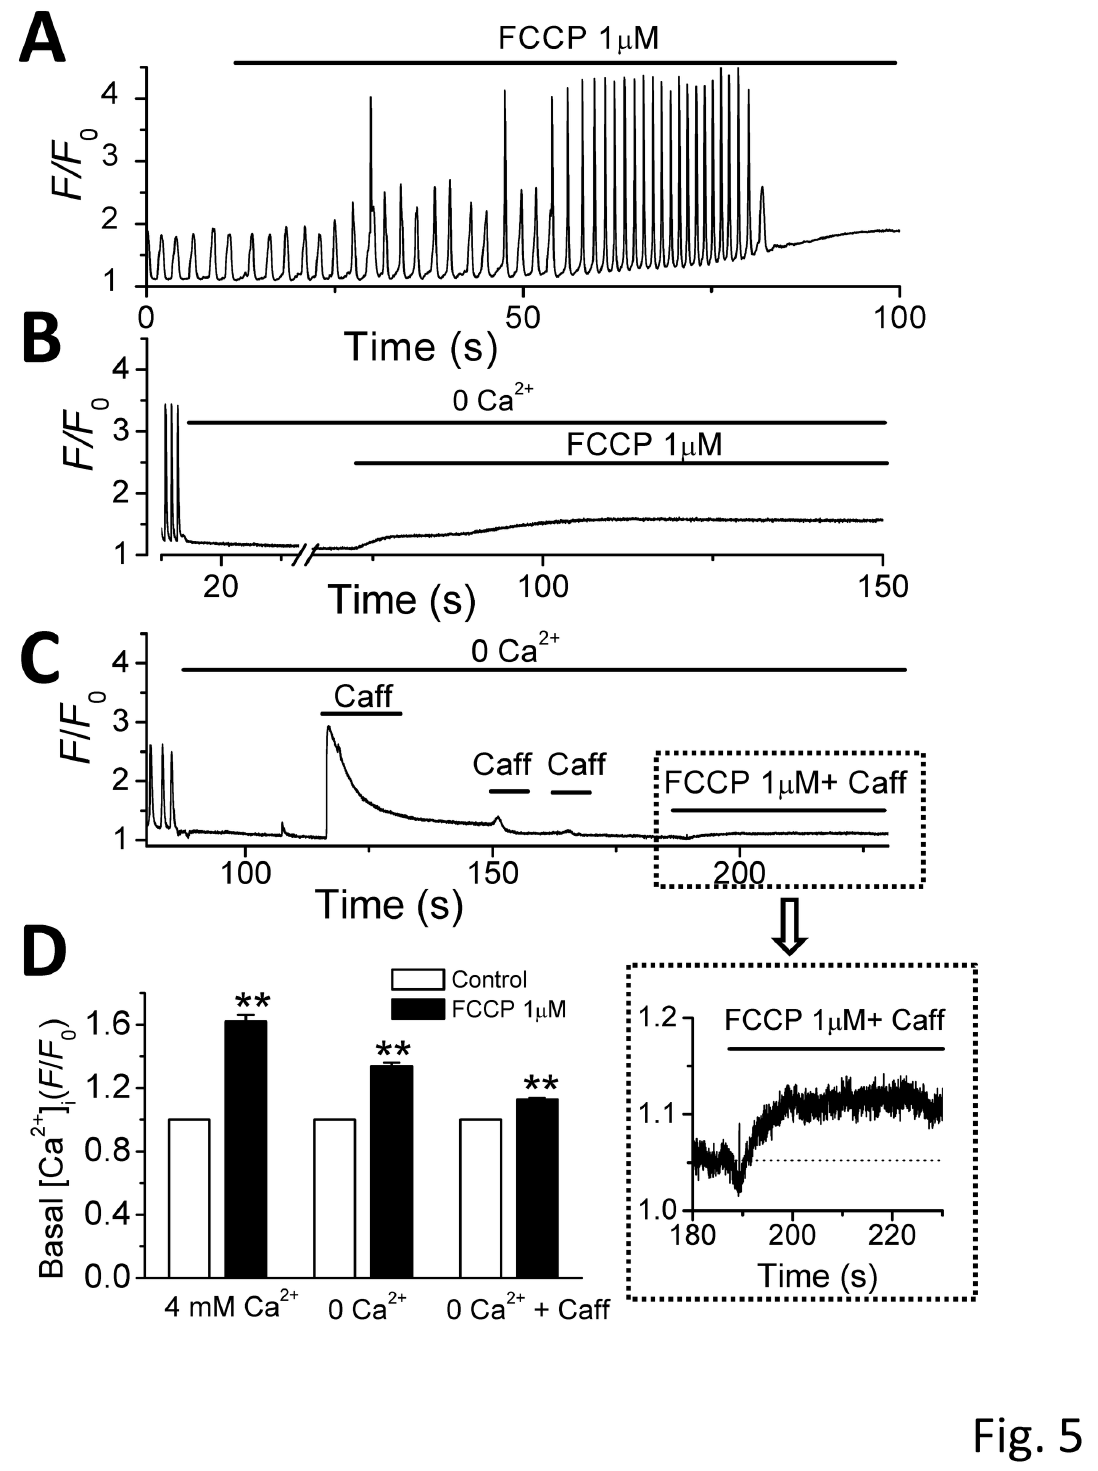
Figure 5. Effect of FCCP on basal [Ca i2+ ] level (mitochondrial Ca 2+ efflux). A . Effects of FCCP (1 µM) on CaWs and basal Ca i2+ level under control condition (4 mM Ca o2+ ). B . Effects of FCCP on basal [Ca i2+ ] level in a Ca o2+ -free condition. C . Effects of FCCP on basal Ca i2+ level in Ca o2+ -free, and SR-Ca depleted condition. D . Summary data showing the effect of 1 µM FCCP on basal Ca i2+ ( ∗∗ p < 0.01 vs. control, n =11). doi: 10.1371/journal.pone.0080574.g005 PLOS ONE |